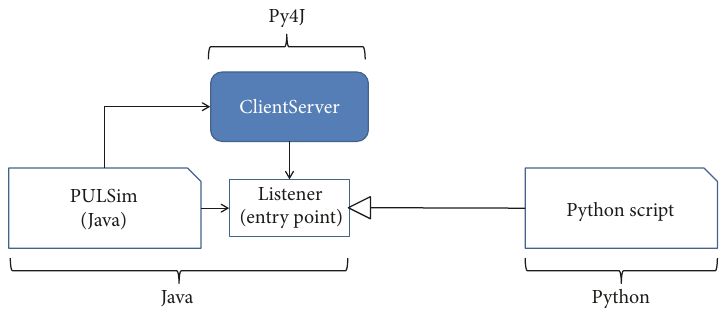
Figure 8: J2Py: accessing Python script from